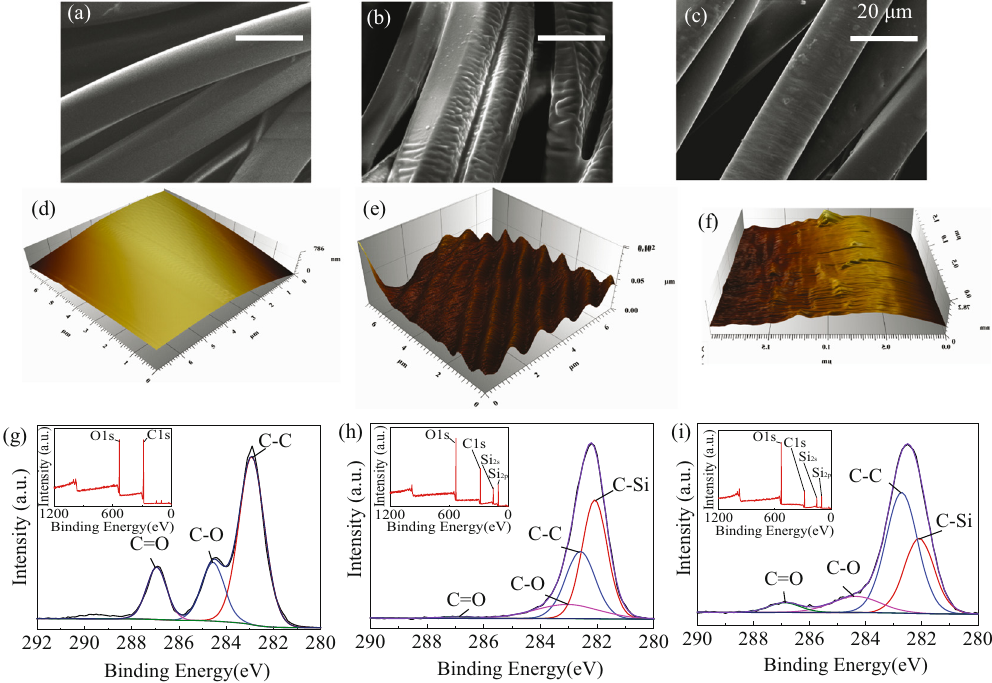
Figure 2: The SEM and AFM images and XPS survey spectra of ( a, d, and g ) PET and PDMS - g - PET fabrics with di ff erent RF power of ( b, e, and h ) 100W, ( c, f, and i ) 250W,